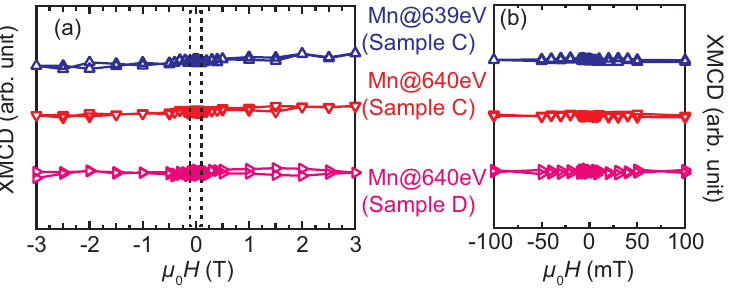
Figure 8. Element-specific MCD hysteresis loops, ESMHs, around the L 3 -absorption edge of Mn for samples C and D, which are antiferromagnetic and paramagnetic Mn 2 VAl films, respectively. ( a ) Full-field range. ( b ) Expanded range surrounded by a broken square in ( a